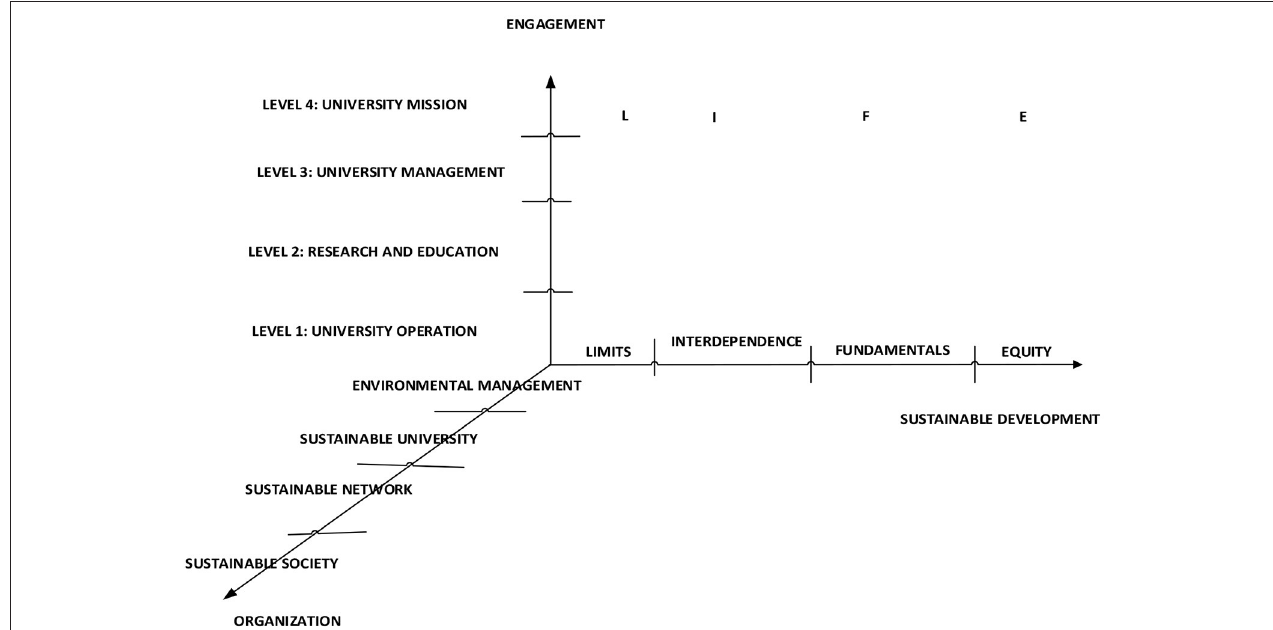
FIGURE 1 | A sustainable university classification model (Van Weenen,